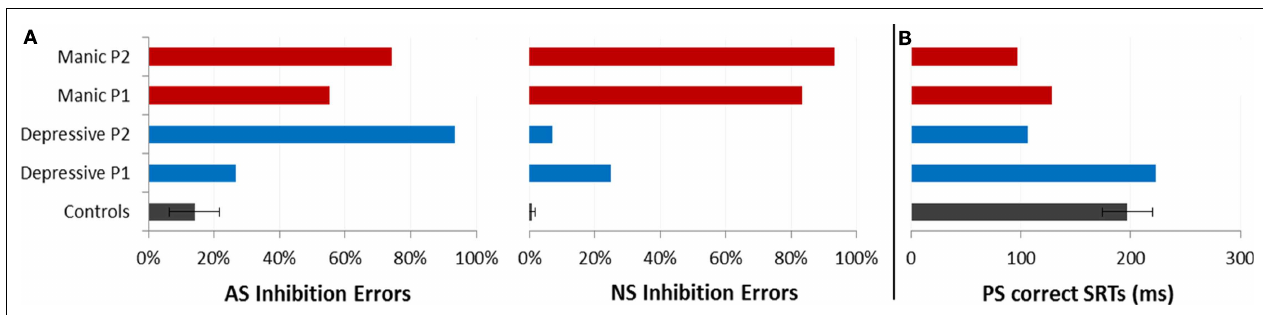
FIGURE 2 | Saccadic performance for each patient as a function of the two opposing illness phases (Depressive and Manic) and for controls ( ± CI). (A) Mean percentages of saccadic inhibition errors in antisaccades (AS) and nosaccades (NS). (B) Mean SRT (in milliseconds) in prosaccades (PS).